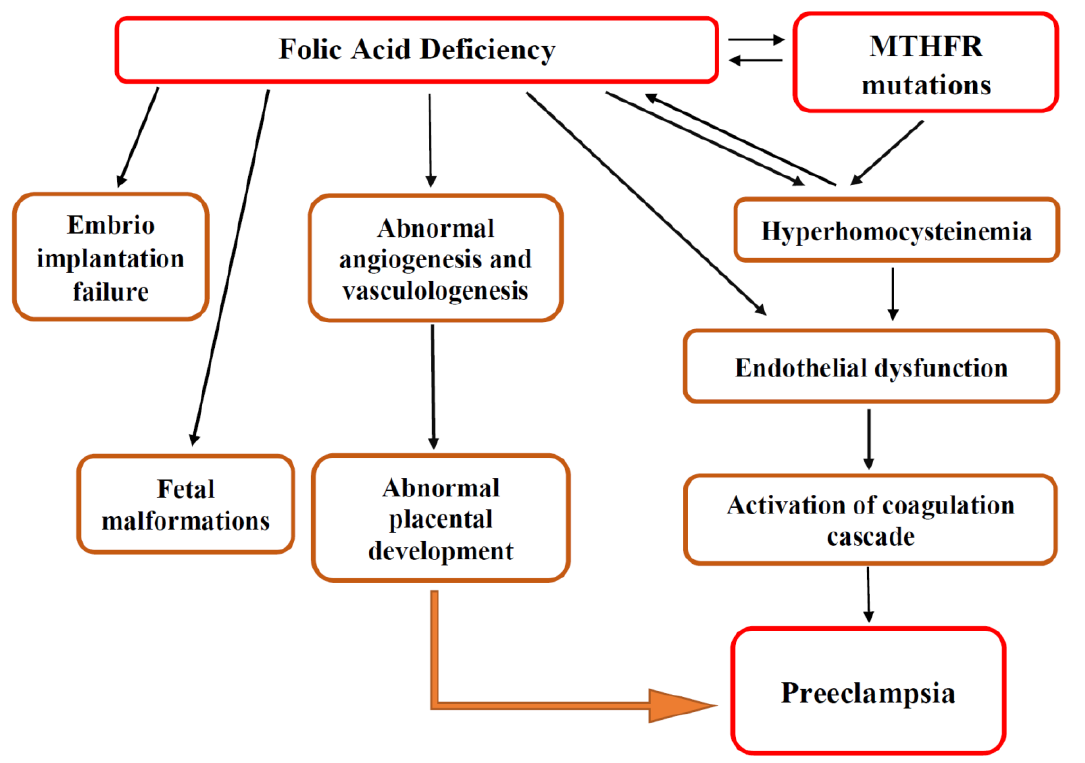
Figure 3. Role of folic acid and MTHFR polymorphisms in preeclampsia. Figure legend: MTHFR—methylenetetrahydrofolate reductase.